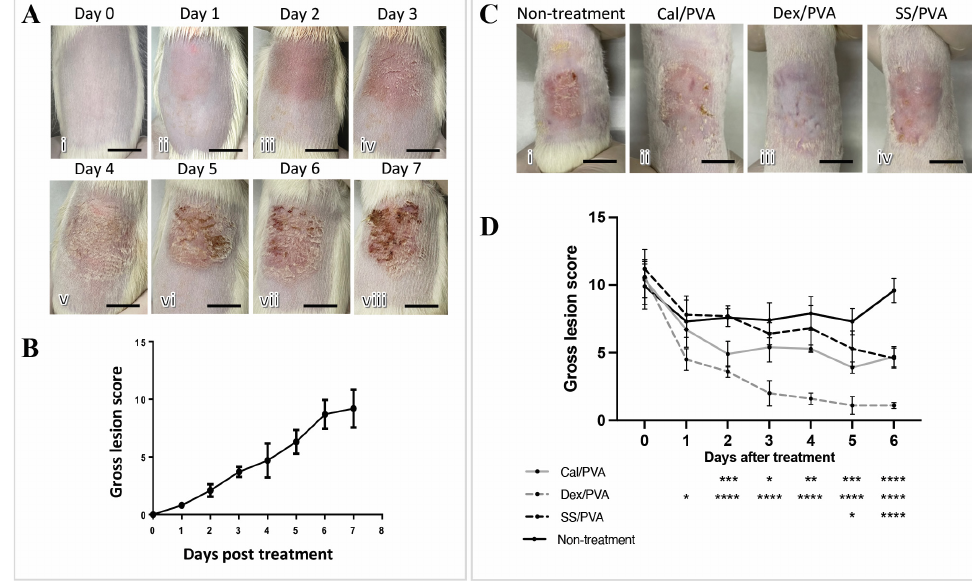
Figure 2. Anatomical appearance scores after treatment in imiquimod-induced psoriatic rat models. ( A ) Gross skin lesions in the induction period from Day 0 to Day 7 ( i – viii ). ( B ) Line graphs of the severity scores of psoriatic lesions in the induction period from Day 0 to Day 7. ( C ) Gross skin lesions in each group after treatment on Day 6 ( i – vi ): ( i ) untreated; ( ii ) calcitriol-based hydrogel treatment; ( iii ) dexamethasone-based hydrogel treatment; ( vi ) sericin-based hydrogel treatment. ( D ) Line graph comparing gross lesion scores after treatment from Day 0 to Day 6 in each group, with the significance level of treated groups compared with the untreated control determined using ANOVA, scale bars ( A , C ) = 0.75 cm. The significant level in the figure was presented as * = p < 0.05 , ** = p < 0.01, *** = p < 0.001, **** = p < 0.0001 .